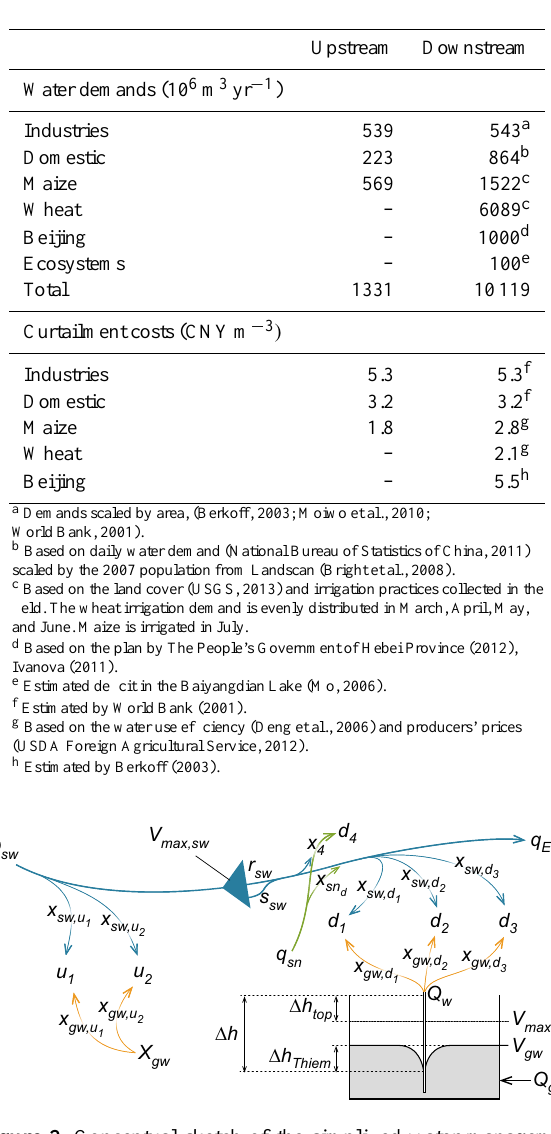
Table 1. Annual water demands and curtailment costs for the users in the Ziya River basin. Based on the data set from Davidsen et al. (2015).